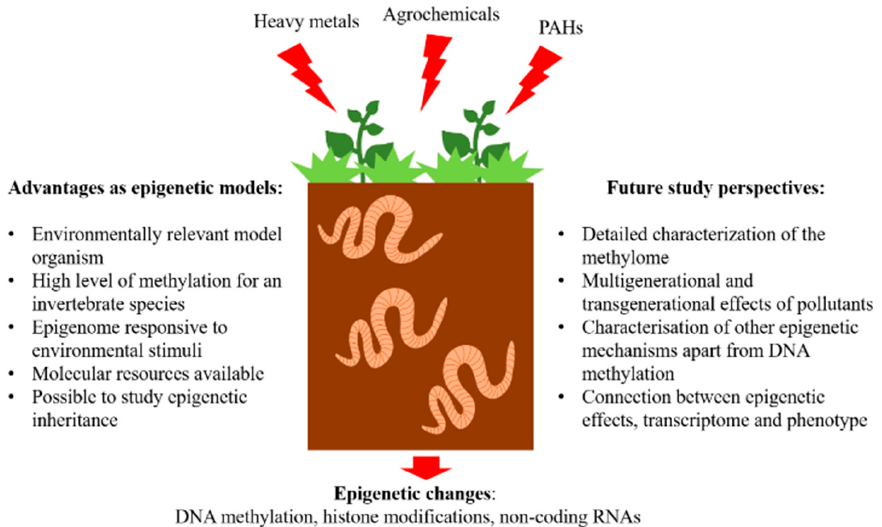
Figure 1. Earthworms as models in environmental epigenetics. Advantages and future study perspectives.